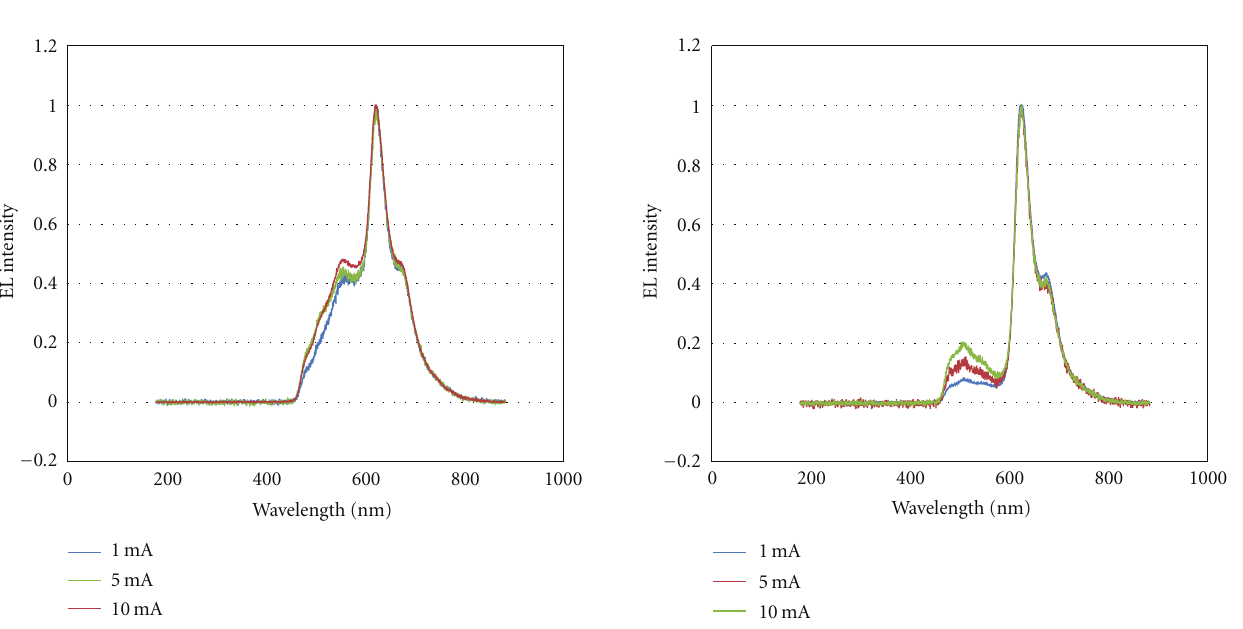
Figure 11: EL spectra in sample E. Injected currents are 1, 5, and 10mA.